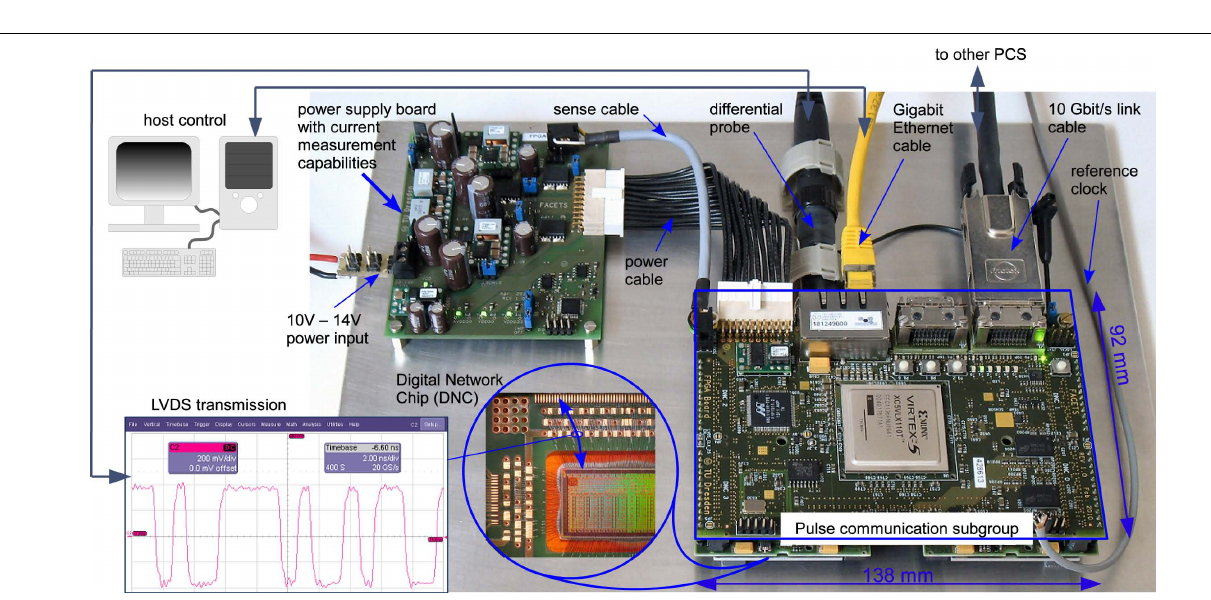
Frontiers in Neuroscience | Neuromorphic